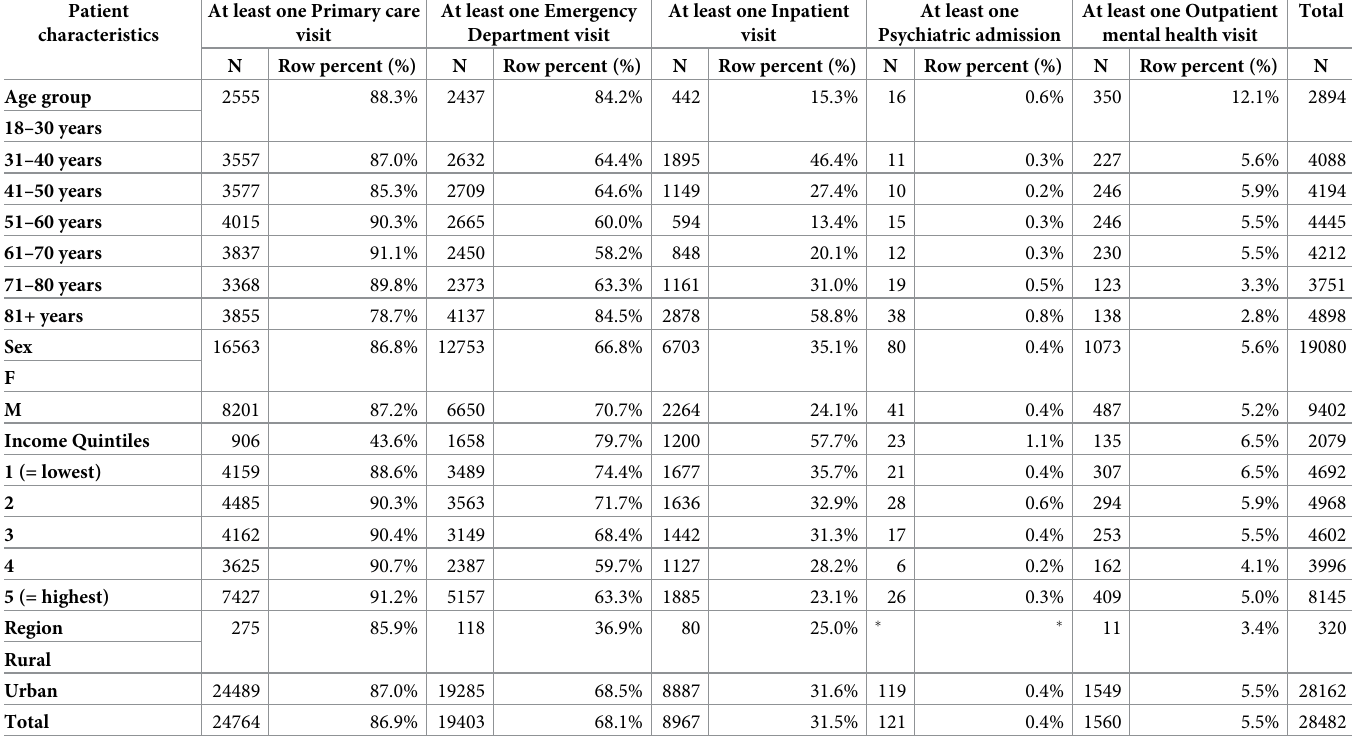
Table 1. Health care utilization among patients in the Health Databank Collaborative from January 1 st 2012 to March 31 st 2019. Patient At least one Primary care characteristics